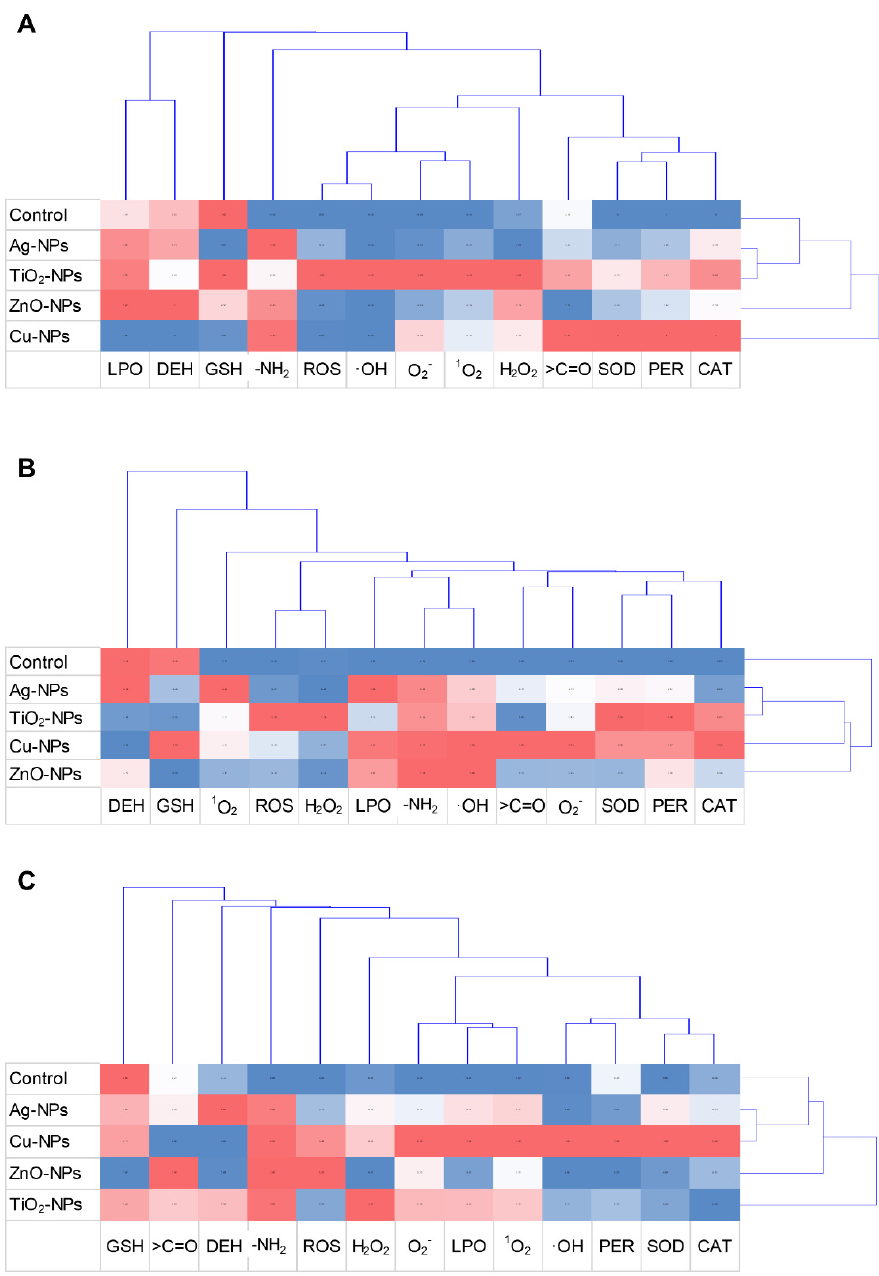
Figure 7. Cluster disposal of free radicals (H 2 O 2 , • OH, 1 O 2 , O 2 •− ), total ROS, GSH, LPO, the content of >C=O and -NH 2 , and CAT, PER, SOD, DEH activities in the control and NPs-treated cells of E. coli ( A ), B. cereus ( B ) and S. epidermidis ( C